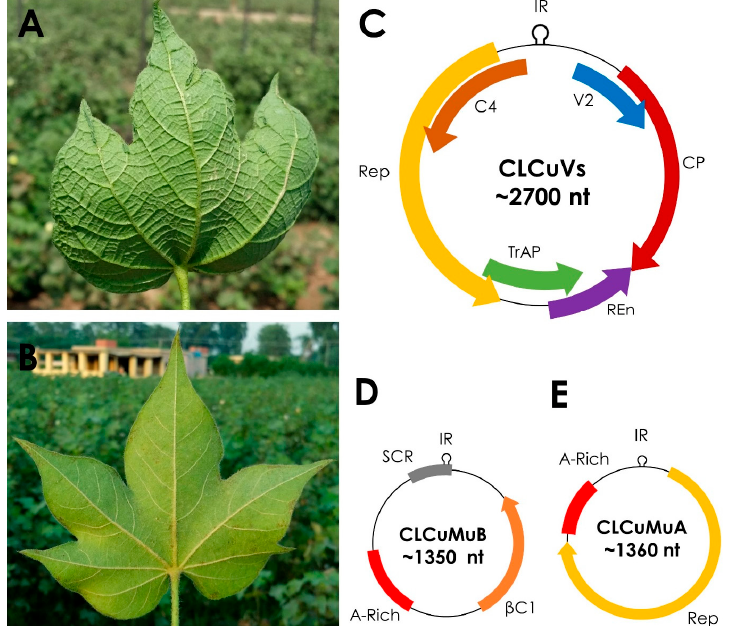
Figure 1. Symptoms of leaf curl disease on cotton and genome organization of the cotton leaf curl disease complex. ( A ) Cotton leaf curl disease (CLCuD) infected Gossypium hirsutum plant’s leaf in a cotton field in Punjab, Pakistan. Typical begomovirus-betasatellite disease complex symptoms like leaf curling, small vein thickening, large vein thickening, and cup shaped leaf, are visible on the lower side of infected leaf, where in panel ( B ) a healthy cotton leaf is free from such symptoms. ( C ) Genome organization of cotton leaf curl disease associated begomoviruses (CLCuVs) having genome of ca. 2700 nucleotides (nt) with four genes in complementary sense orientation encoding for replication associated protein (Rep), transcriptional activation protein (TrAP), replication enhancer protein (REn) and C4 protein; and two genes in virion sense orientation encoding for coat protein (CP) and V2 protein. ( D ) Cotton leaf curl Multan betasatellite (CLCuMuB) has a genome of ca. 1350 nt and encodes for a single β C1 protein. Non-coding region of CLCuMuB contains satellite conserved region (SCR) and adenine-rich (A-rich) region. ( E ) Cotton leaf curl Multan alphasatellite (CLCuMuA) has a genome of ca. 1370 nt and encodes for Rep. A-rich region is also present in